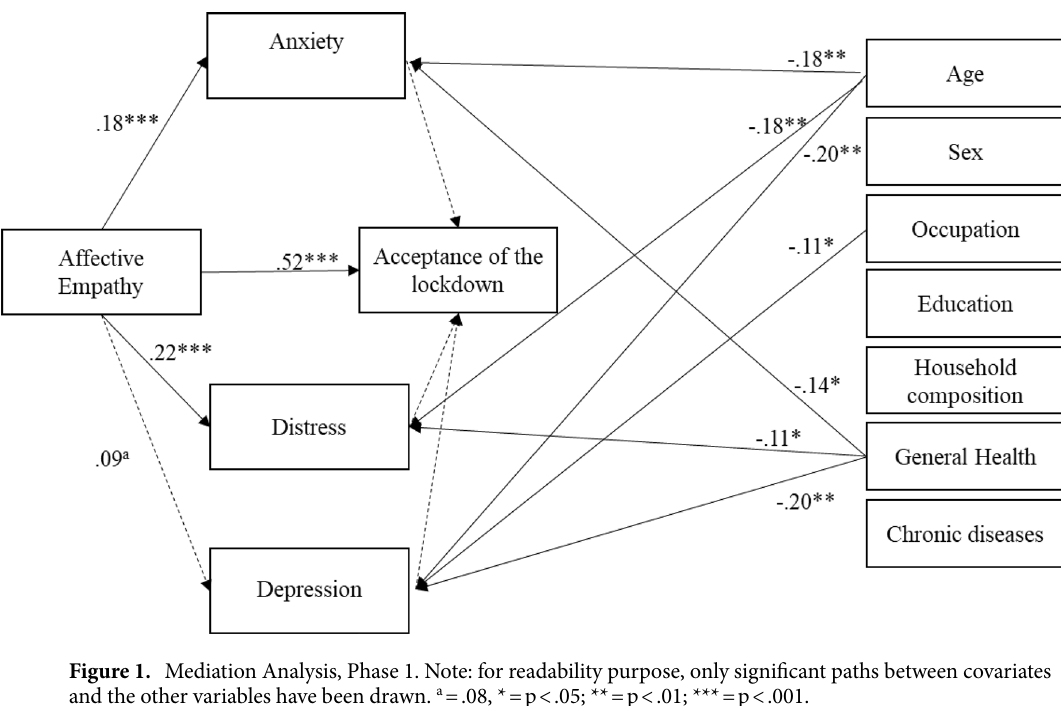
Figure 1. Mediation Analysis, Phase 1. Note: for readability purpose, only significant paths between covariates and the other variables have been drawn. a = .08, * = p < .05; ** = p < .01; *** = p < .001.